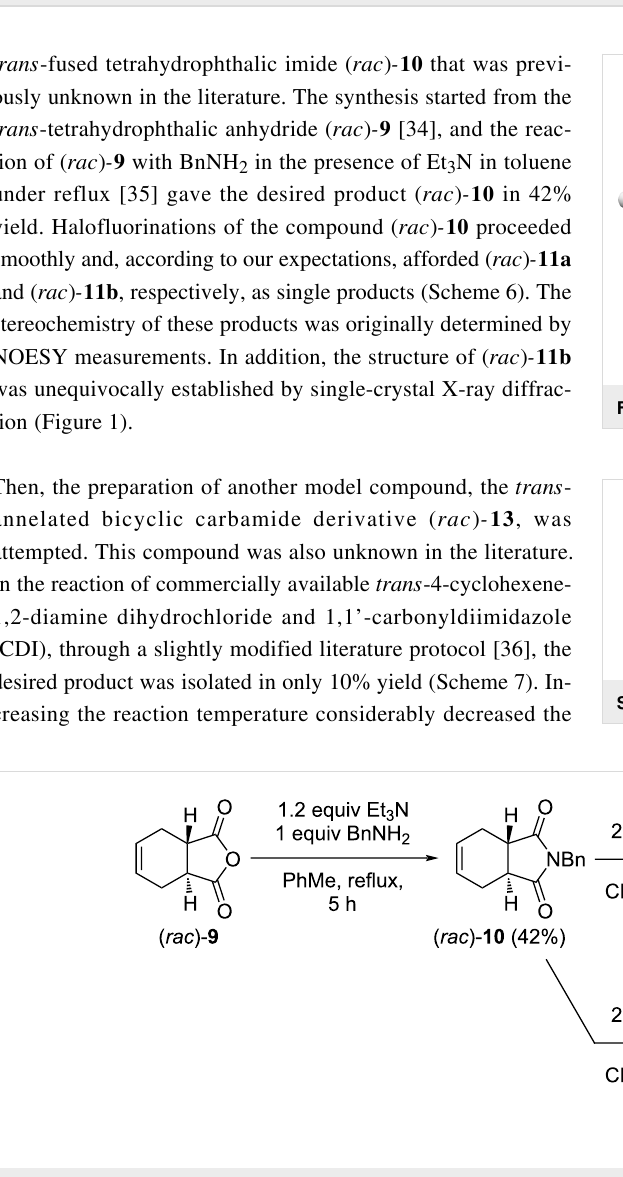
Scheme 6: Synthesis and halofluorination of the trans -imide ( rac ) - 10 .